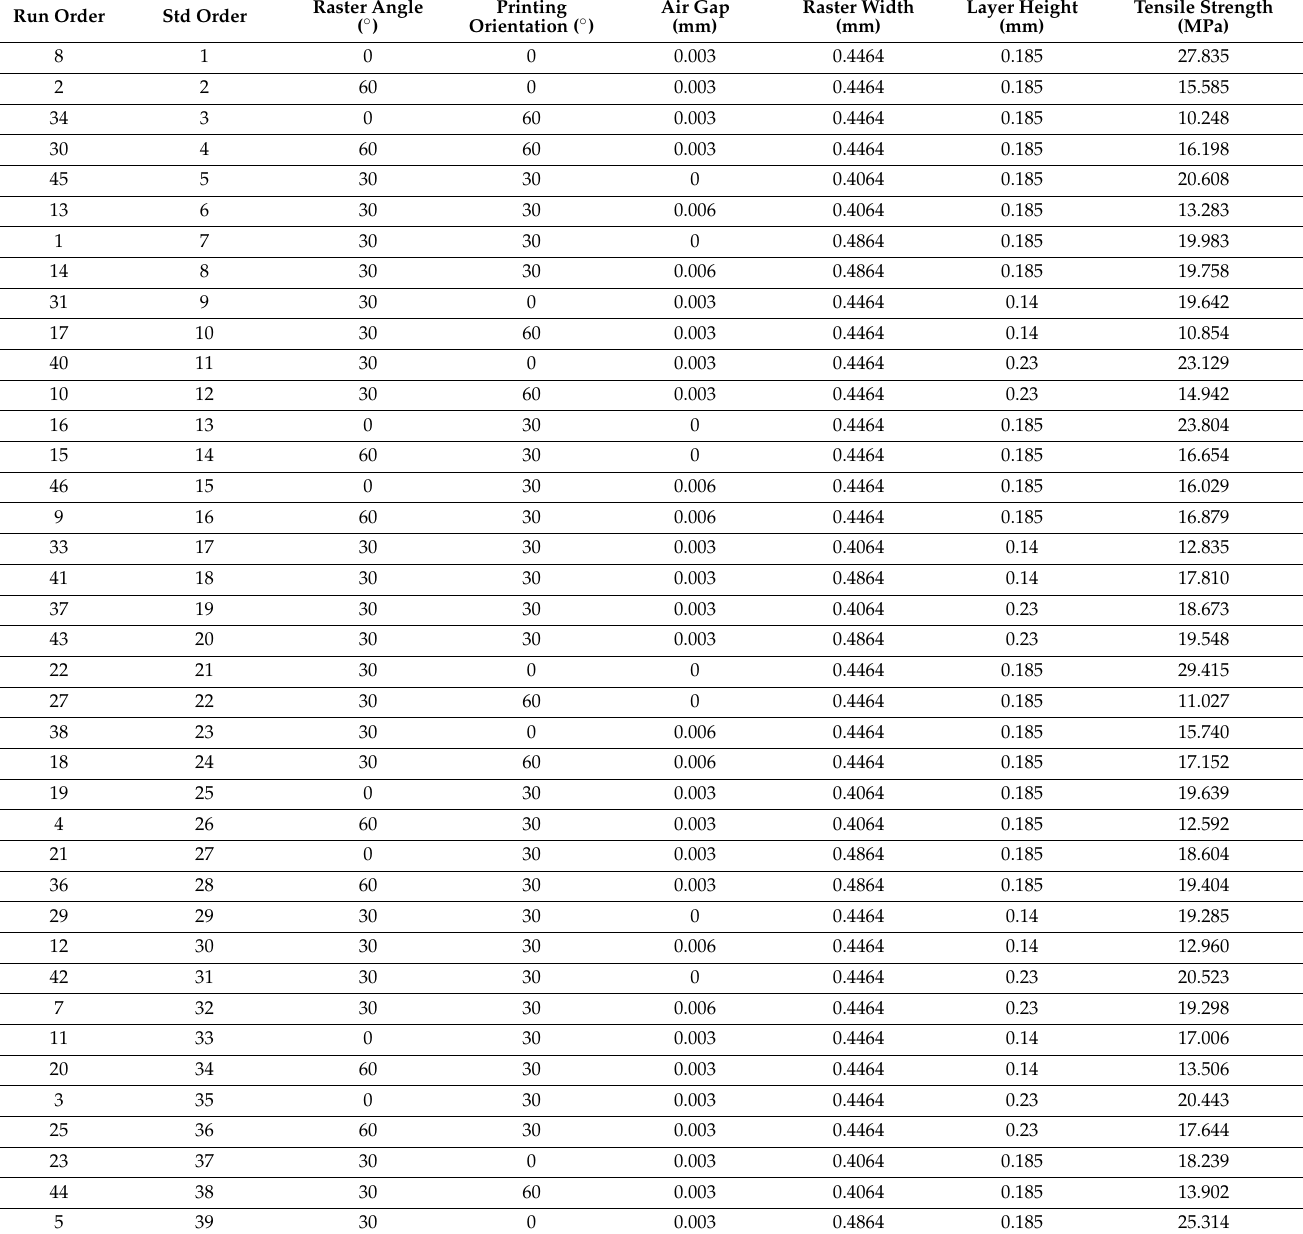
Table 4. Box—Behnken response surface experimental design matrix and measured